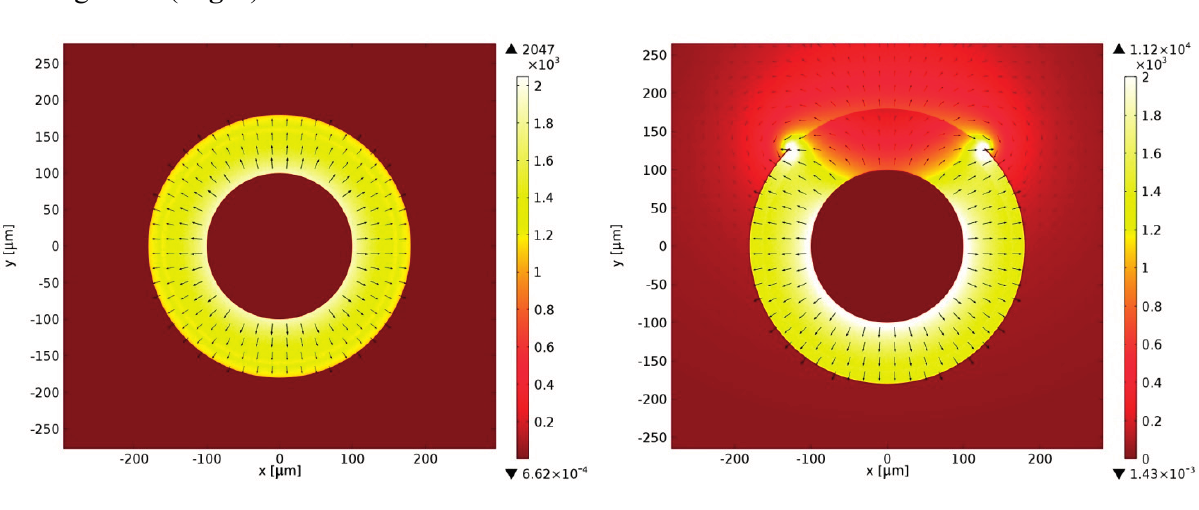
Figure 7. E-field simulation of the propagation of a TEM-like mode inside the windowless segments of the LCX ( Left ); and coupling to radiation modes in the windowed segments ( Right ).